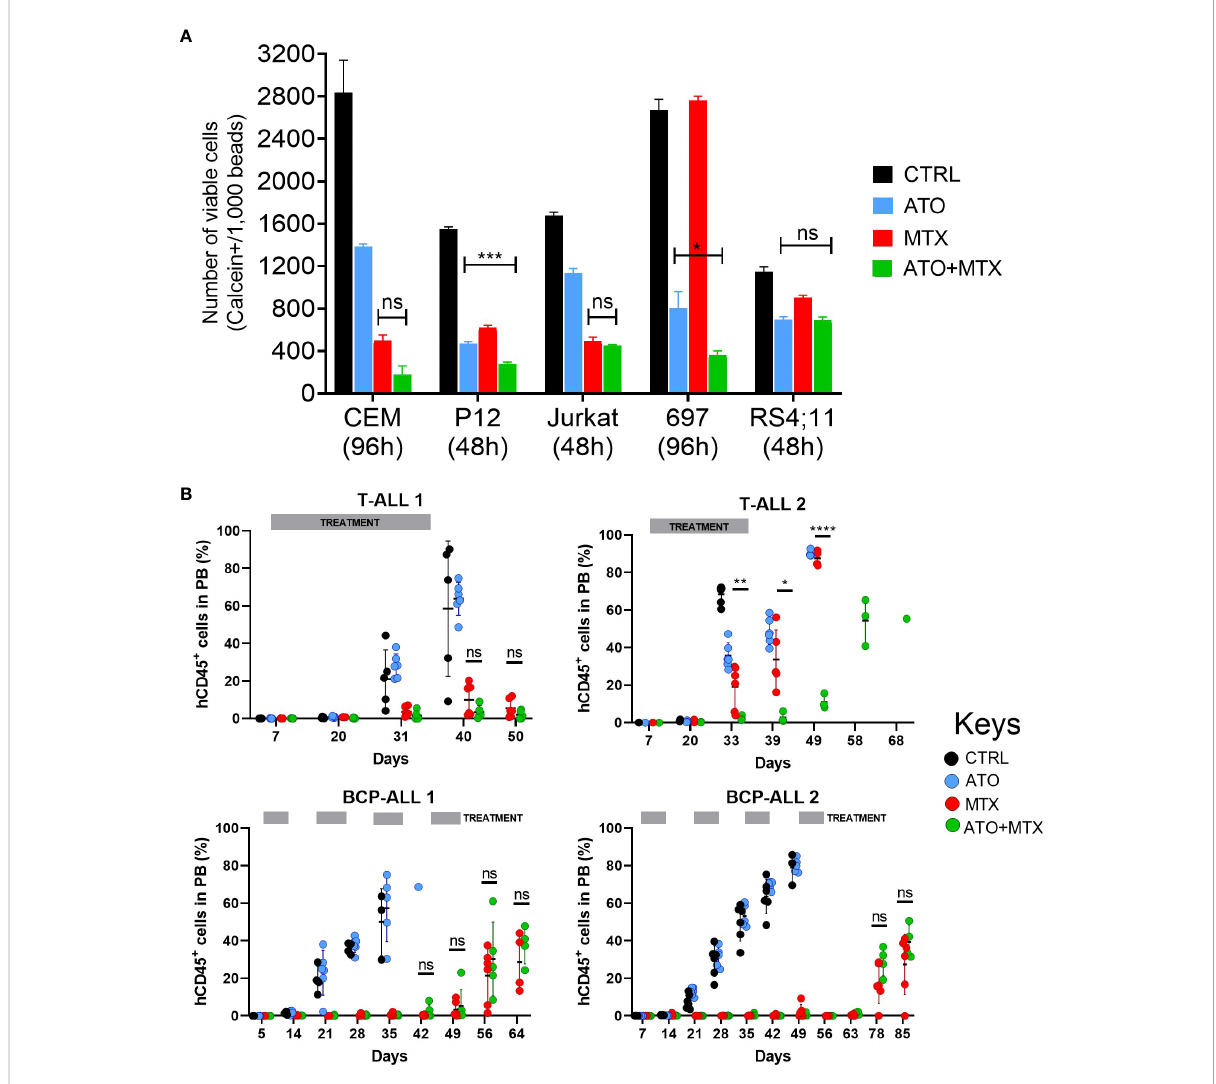
FIGURE 5 Combination of ATO and MTX in vitro and in PDX models of ALL. (A) Cell survival accessed by fl ow cytometry analysis of calcein-positive cells. The number of viable calcein+ cells per 1,000 fl uorescent beads (spike in) was determined after 48 or 96 hours, as indicated. MTX was added at time zero while ATO was added at half-time. Results are the mean ± standard error (SE) of triplicate samples. P -values for Tukey ’ s Test following ANOVA. * P <0.05; *** P <0.001. Doses used: CCRF-CEM: ATO = 1.5 µM, MTX = 12.5 nM; P12-ICHIKAWA: ATO = 3 µM, MTX = 13 nM; Jurkat: ATO = 1.5 µM, MTX = 36 nM; RS4;11: ATO = 1.4 µM, MTX = 18 nM; 697: ATO = 0.75 µM, MTX = 6 nM. (B) Human CD45-positive (hCD45+) leukemia cells in peripheral blood of PDX-transplanted NSG mice, accessed by fl ow cytometry. Treatment started one week after engraftment when hCD45+ cells > 0.5% in half of the mice (Day 7) and was administered for 4 consecutive weeks against T-ALL or every other week against BCP-ALL. Doses used: MTX = 10 mg/kg daily (T-ALL) or 5 mg/kg daily (BCP-ALL); ATO = 2.5 mg/kg daily; ATO was administered 6 hours after MTX in the co-treatment cohort. L.E. = leukemia engraftment period. P -value for Log-rank test. P -value for unpaired t test between MTX and ATO+MTX. * P ≤ 0.05; ** P ≤ 0.01; **** P ≤ 0.0001; ns, not signi fi